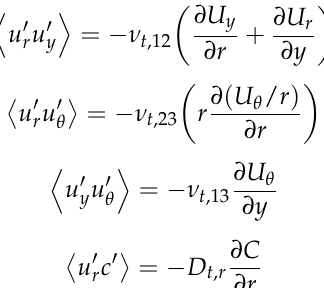
Figure 8. ( a ) Turbulent viscosity, ( b ) turbulent diffusivity, and ( c ) turbulent Schmidt number for nonswirling jet.